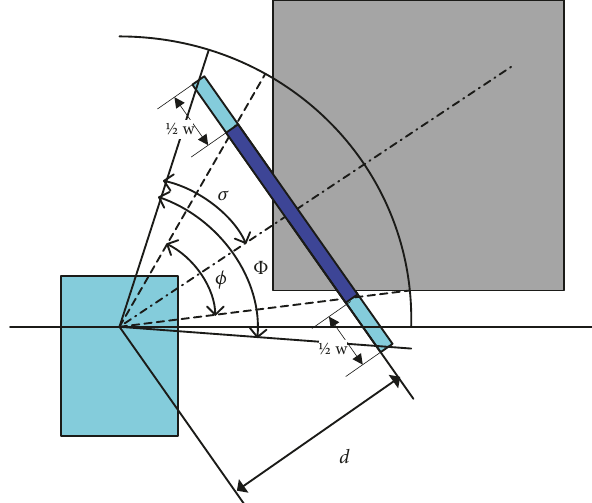
Figure 7: Enlarging the angle occupied by obstacles.